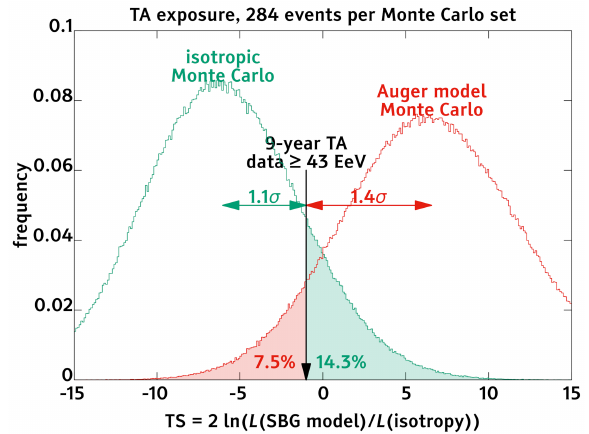
Figure 4. The test statistic value we obtained for our data